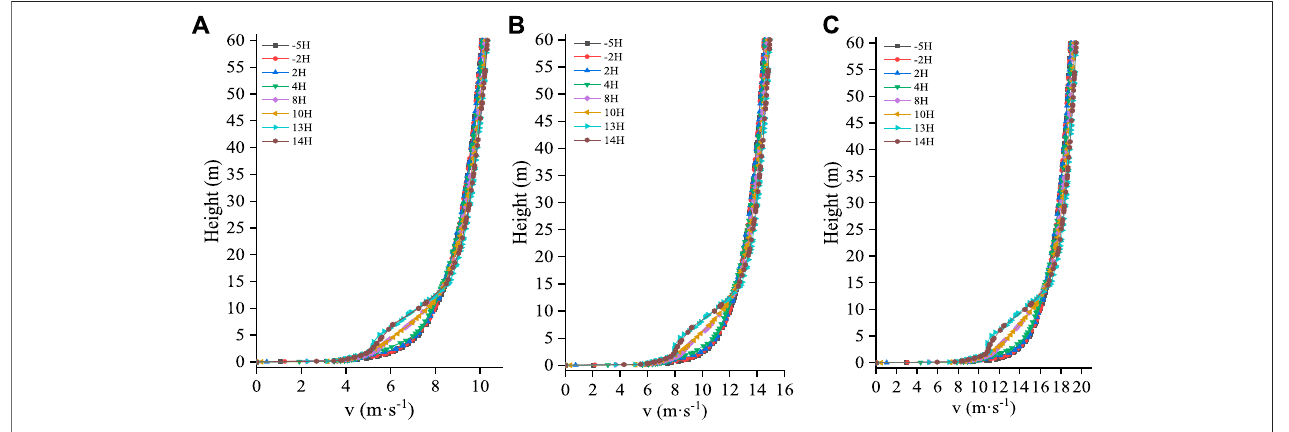
FIGURE 7 | Wind velocity pro fi le variations at different positions of double-row forest belt under different incoming wind velocities. (A) :V = 8 m · s − 1 , (B) : V = 12 m · s − 1 , (C) : V = 16 m · s − 1 .